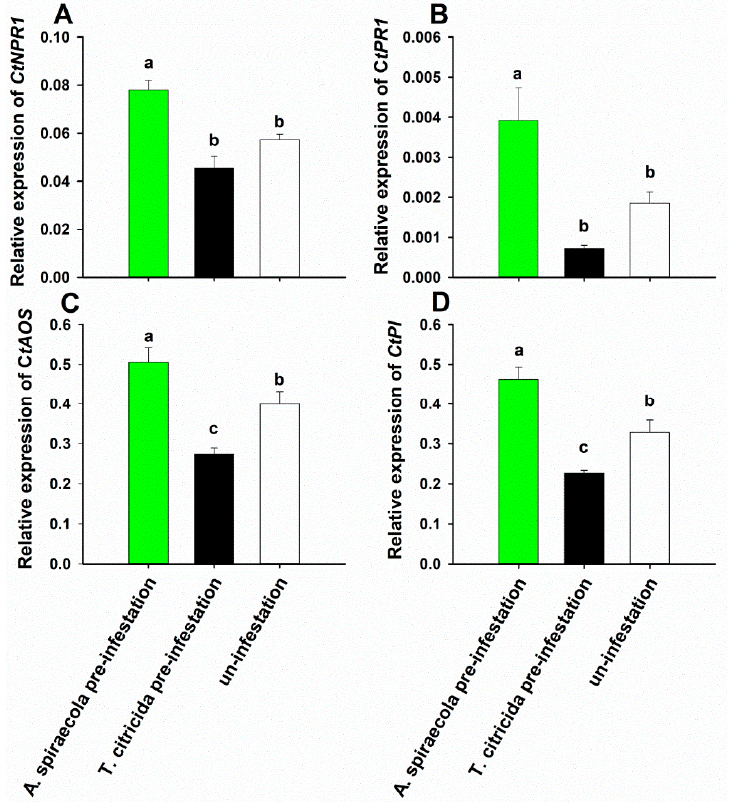
Figure 5. Relative expression of salicylic acid ( A , B ) and jasmonic acid ( C , D ) marker genes in A. spiraecola pre-infested, T. citricida pre-infested, or un-infested sweet orange. Gene expression levels were evaluated relative to CtGAPC . Values represent the mean ± SE (n = 4). Bars with different letters represent significant difference (Tukey’s HSD test, p < 0.05).